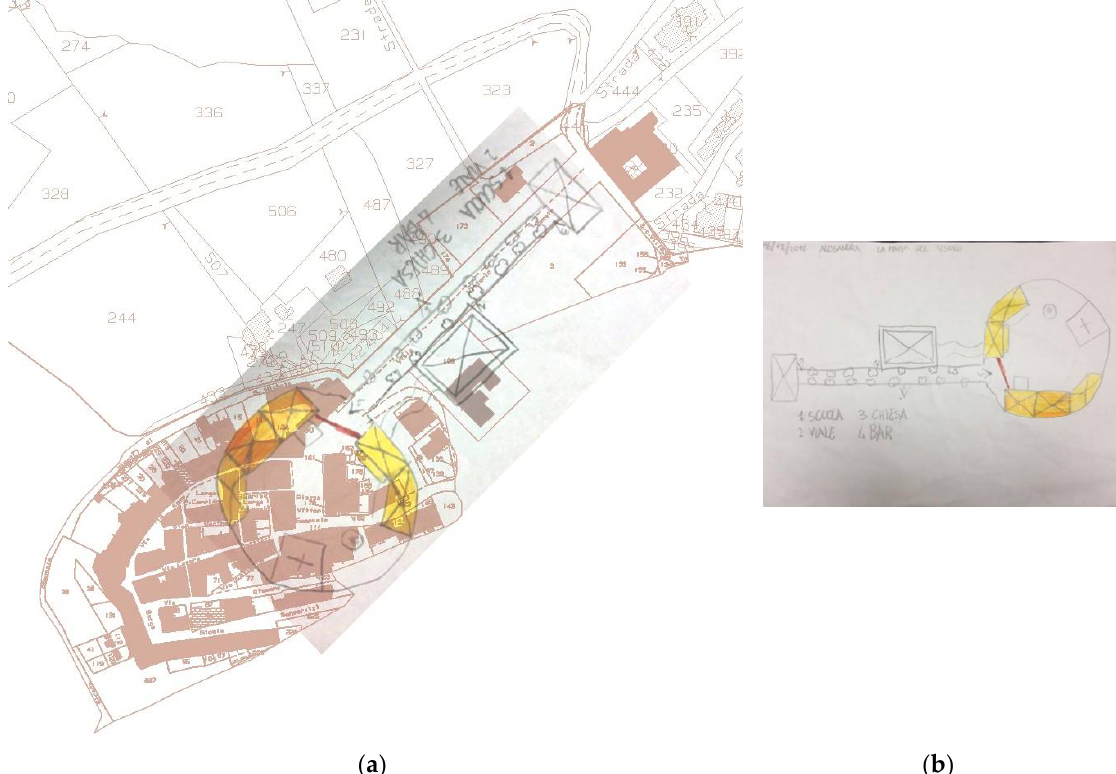
Figure 6. Gualdo from the free-hands memory drawings. ( a ) The cadastral map overlapped to a child drawing (December 2016, graphic processing IP). ( b ) The very symbolic map of the school in relation to the surroundings (drawing